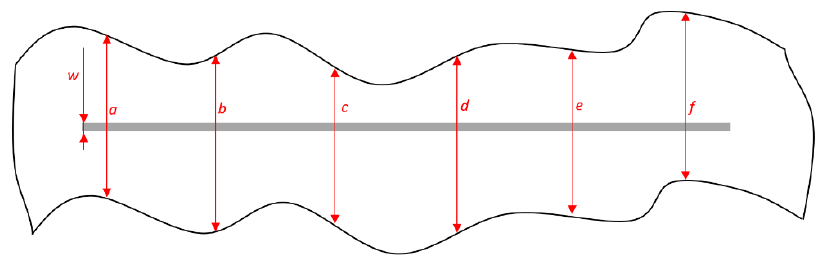
Figure 8. Measuring the size of corrosion product spread on specimen.